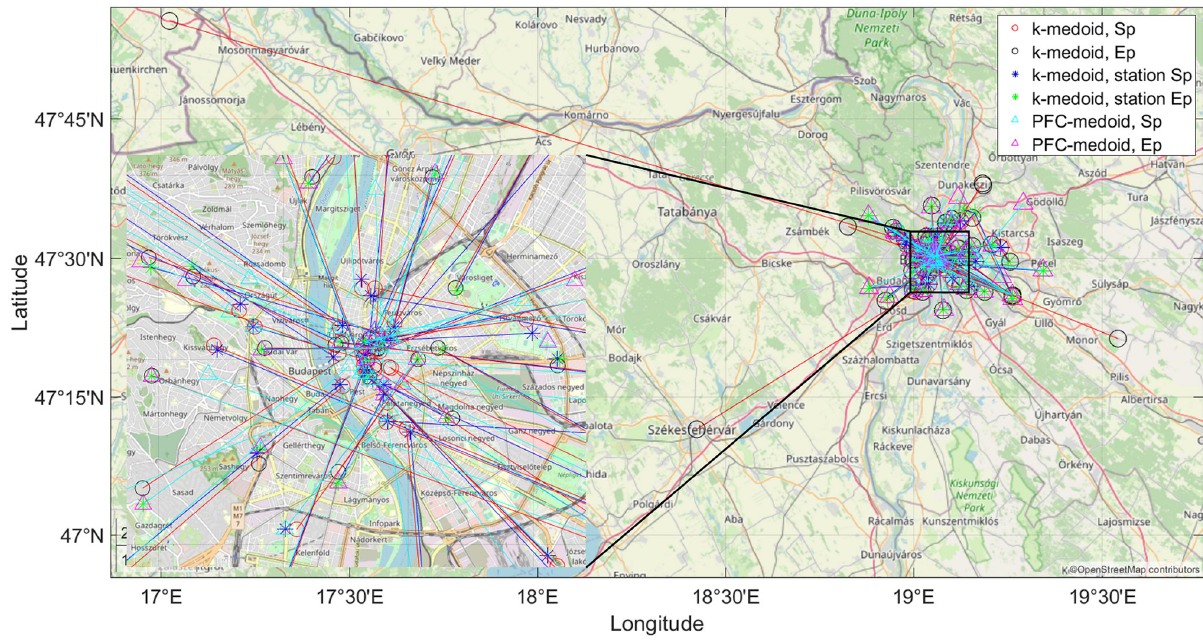
Fig 2. The start- and end-points (Sp and Ep, respectively) of the k-medoid clustering of the Taxicab rides are marked with red and black circles, respectively. The nearest public transportation stops to these start- and end-points are marked by black (Sp) and green (Ep) asterisks. In contrast, the clusters designed by the PFCMD algorithm are marked with cyan (Sp) and magenta (Ep) triangles, respectively. The colour of the line connecting the related stations in a straight line is the same as the colour of the starting station. The problem of outliers is well-reflected in the case of the trip to Vienna (red line on the left side of the figure) and constraining the solution to the outermost public transportation stop does not solve the problem neither.